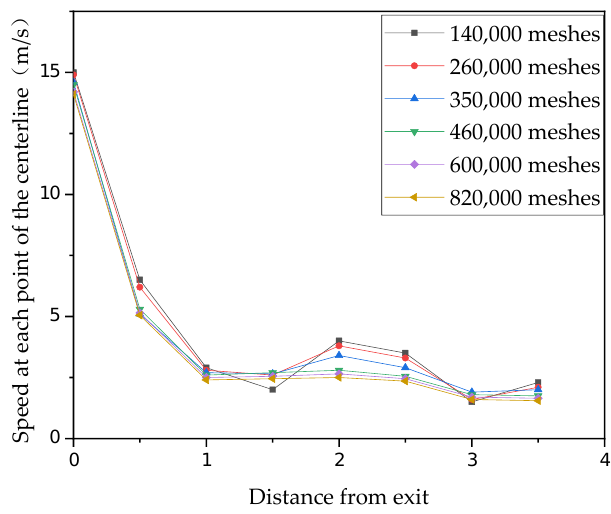
Figure 5. Speed of mesh detection points with different sizes.